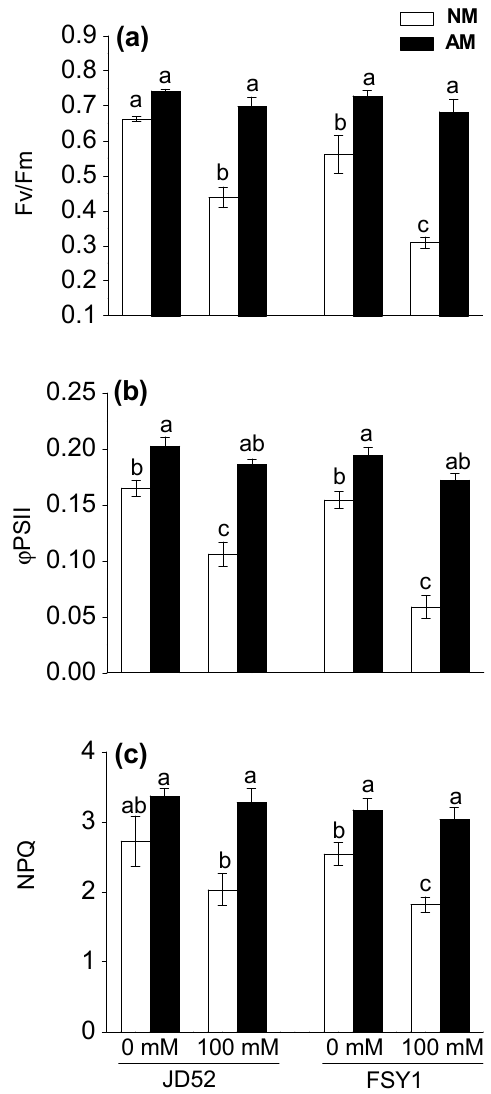
Figure 3. Maximum quantum yield of PSII photochemistry (Fv/Fm) ( a ), actual quantum yield of PSII photochemistry ( ϕ PSII) ( b ), and non-photochemical quenching (NPQ) ( c ) in two maize genotypes (JD52 and FSY1) inoculated with Funneliformis mosseae (AM) or without inoculation (NM) in 0 and 100 mM NaCl treatments assessed at 59 DAS. For each trait, bars with different letters indicate significant differences ( p ≤ 0.05).